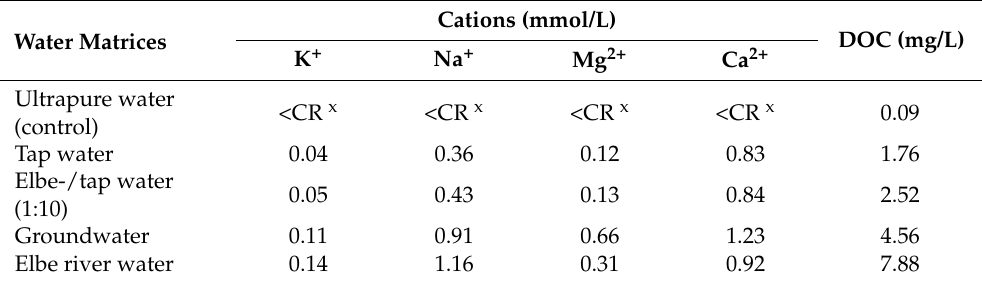
Table 3. Initial cation and DOC concentrations of the natural water matrices